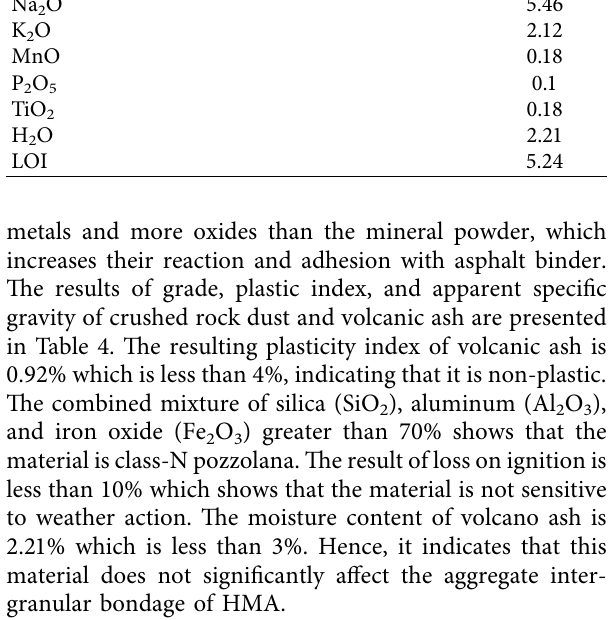
Figure 2. As confrmed in Table 5, the bulk specifc surface area and mass specifc surface area of CSD are much smaller